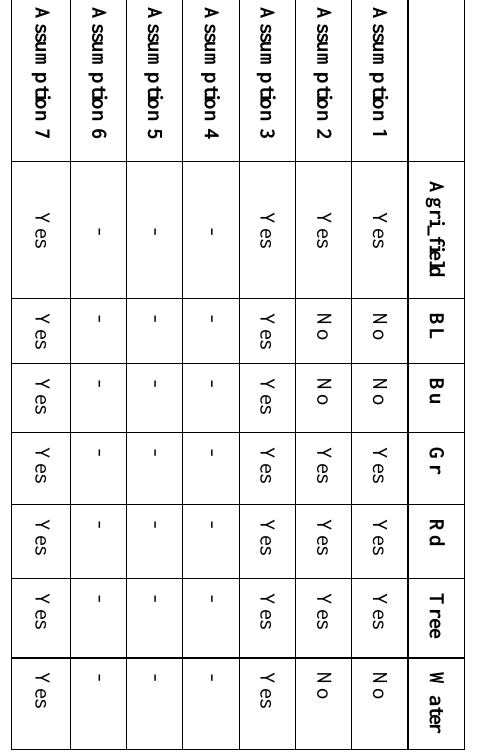
Table 4. Summary of which classes satisfy each